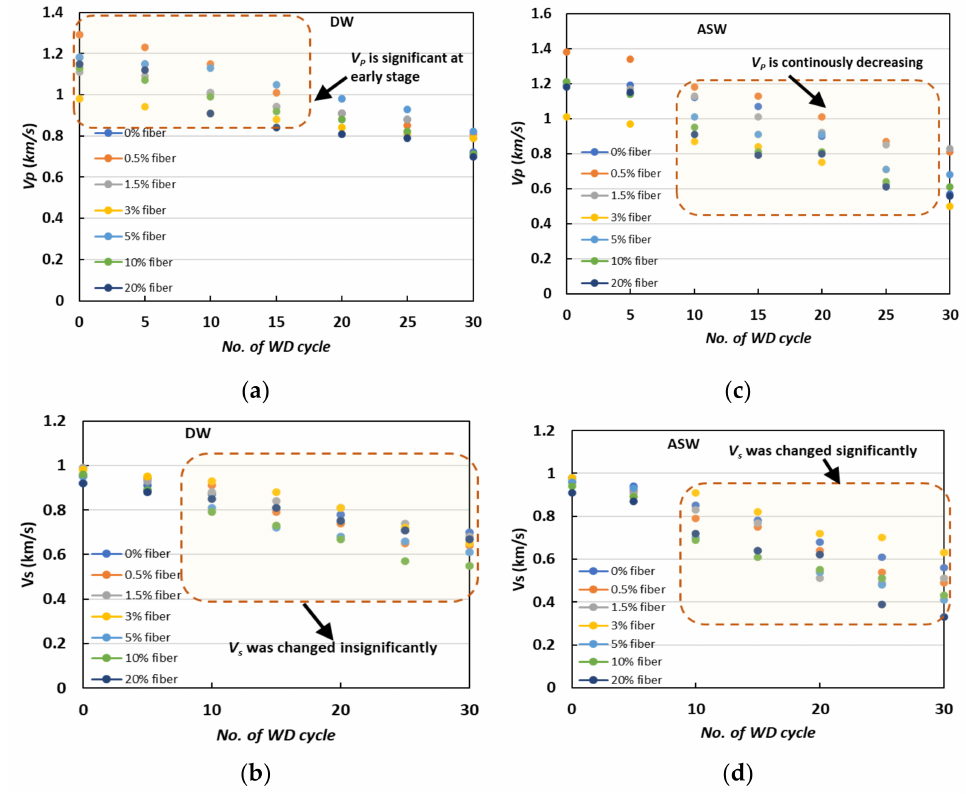
Figure 7. Variations in the shear-wave velocity of specimens under exposure to cyclic WD tests: ( a ) P-wave velocities in DW; ( b ) S-wave velocities in DW; ( c ) P-wave velocities in ASW; ( d ) S-wave velocities in